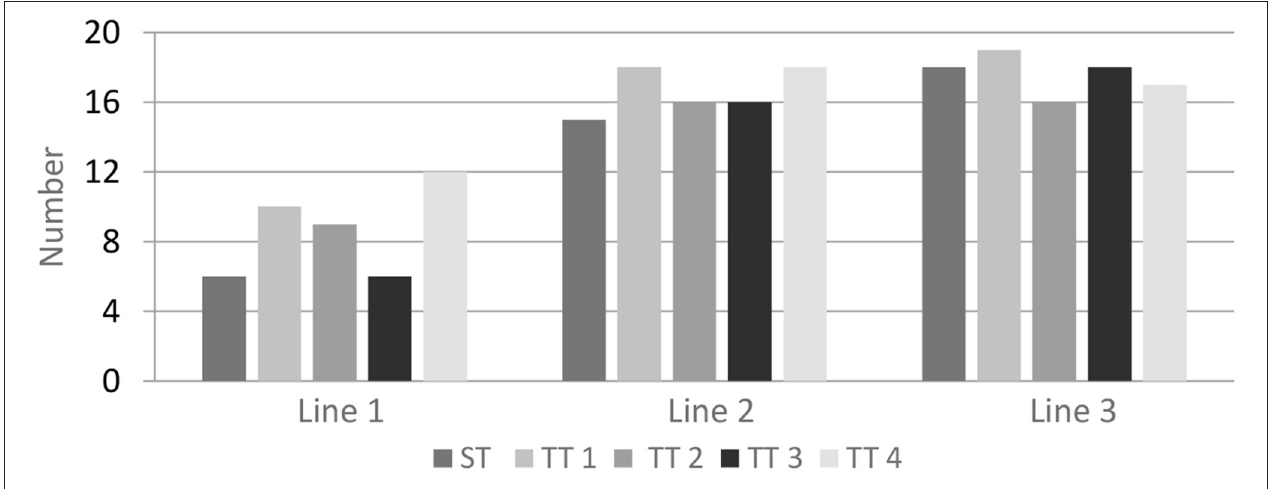
FIGURE 2 | Recognition of imagery